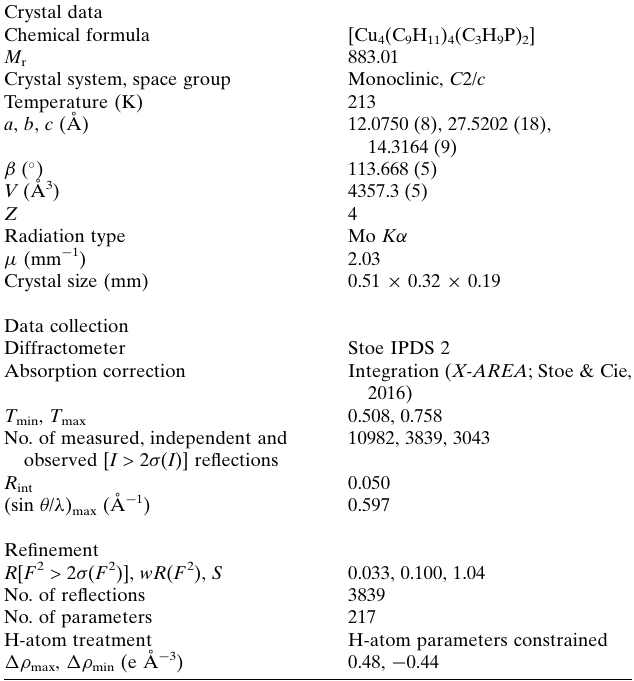
Table 2 Experimental details. Crystal data Chemical